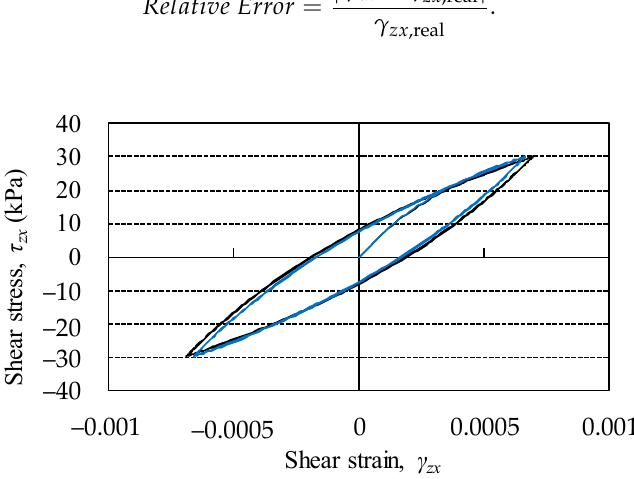
Figure 5. The comparison between the shear stress–shear strain relation of the original model with the proposed model. Black line is shown as the response of the original model and blue line is shown as that of the proposed model.